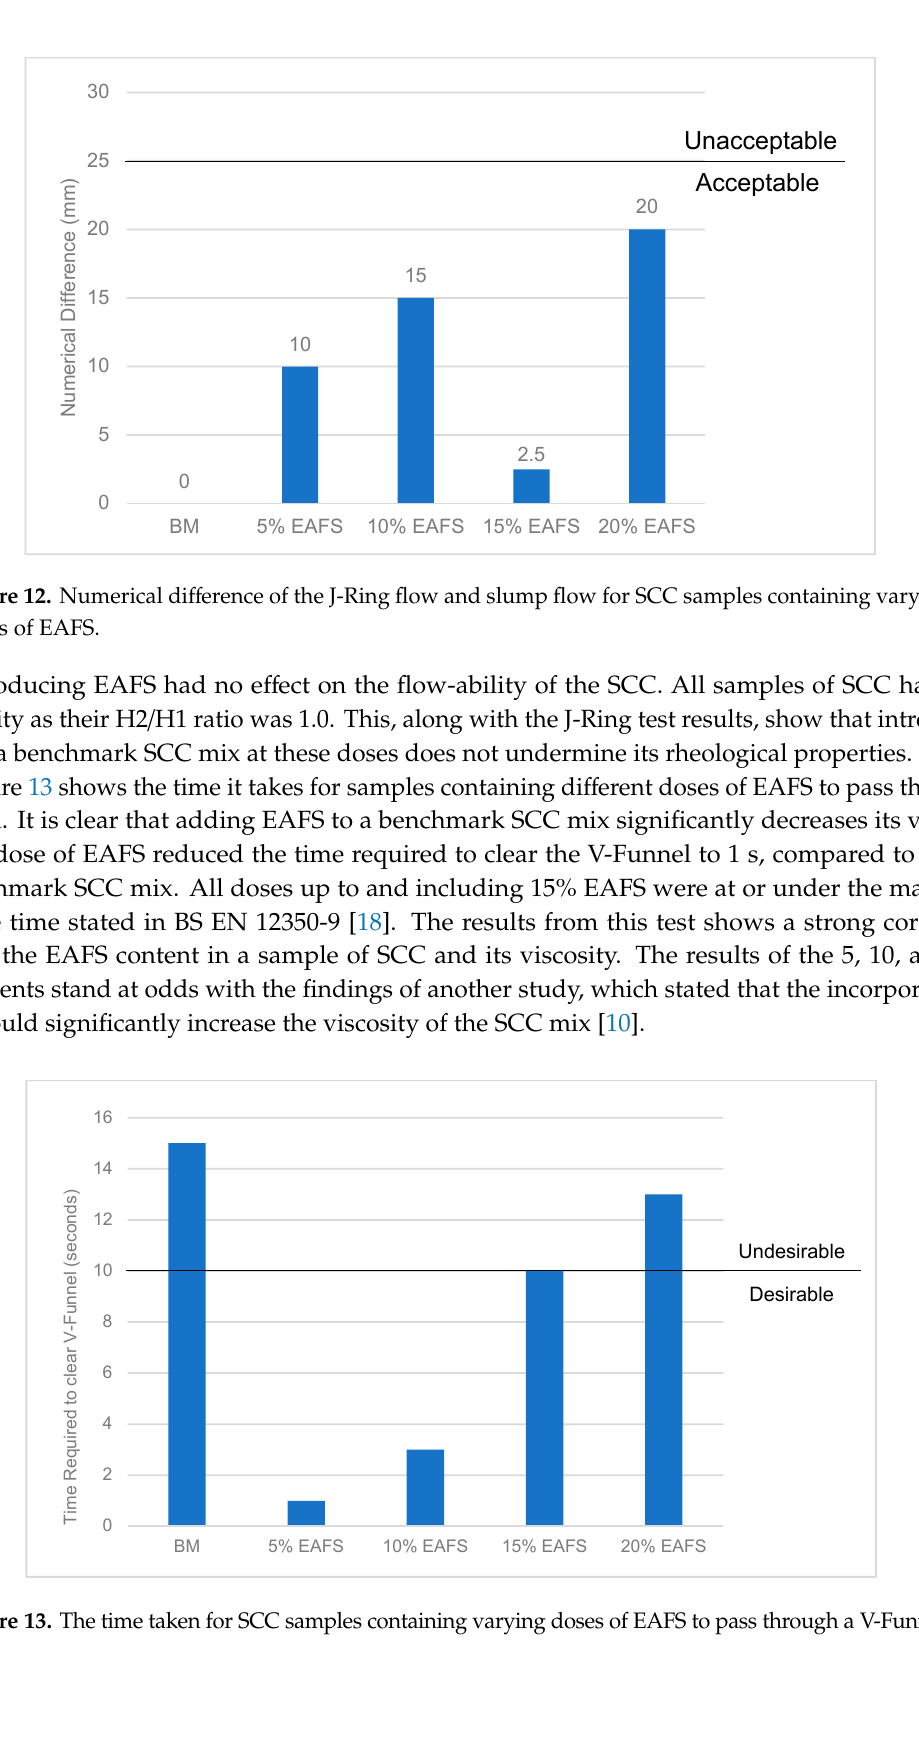
Figure 11. Results of the J-Ring flow and slump flow for SCC samples containing varying doses of EAFS.